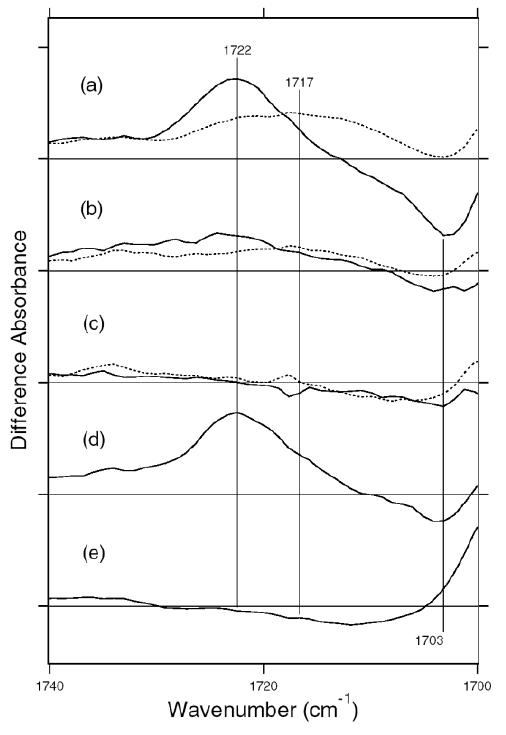
Figure 36. The ASR minus ASR infrared spectra of the wild type at pH 5 (a), pH 7 (b), L and pH 9 (c), D217N at pH 5 (d) and E36Q at pH 5 (e) in the 1,740–1,700 cm -1 region. The sample was hydrated with H O (solid lines) or D O (dotted lines). One division of the y-axis 2 2 corresponds to 0.0008 absorbance units. This figure is reprinted with permission from Kawanabe et al [77]. Copyright 2008 American Chemical